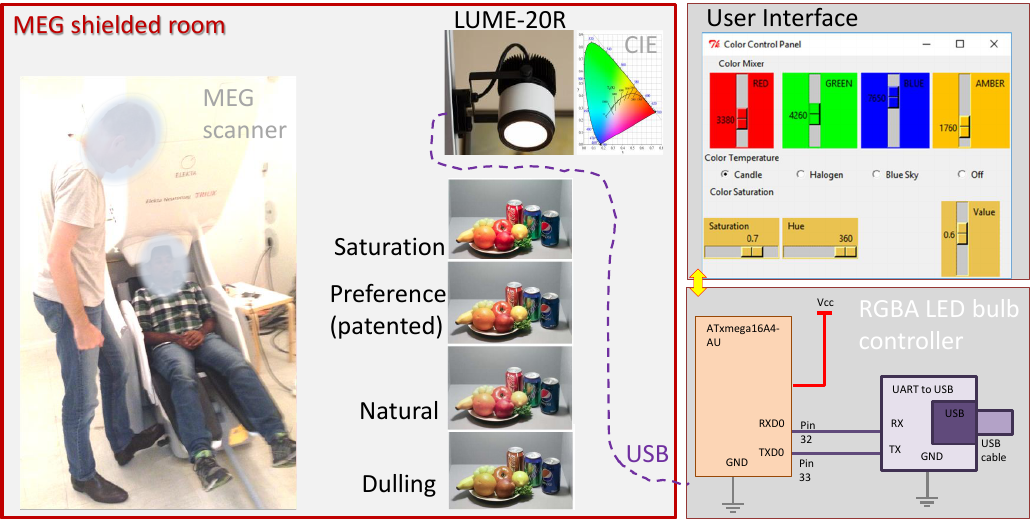
Figure 1. A magneto-encephalography (MEG) brain scanning experiment carried out with four-color RGBA (amber is added) illumination; the Elekta/Neuromag 306 channel MEG system was used. Different illumination was defined as: saturation, preferential, natural, and dulling [6], which were selected by RBGA mixture from the CIE 1931 chromaticity diagram; the preferential illumination was patented. The LUME-20R lamp was used in this study; its control via USB connection and the user interface were developed in this project (see details in Figure 2). Photo: C.W. in MEG scanner and W.W. setting MEG up.